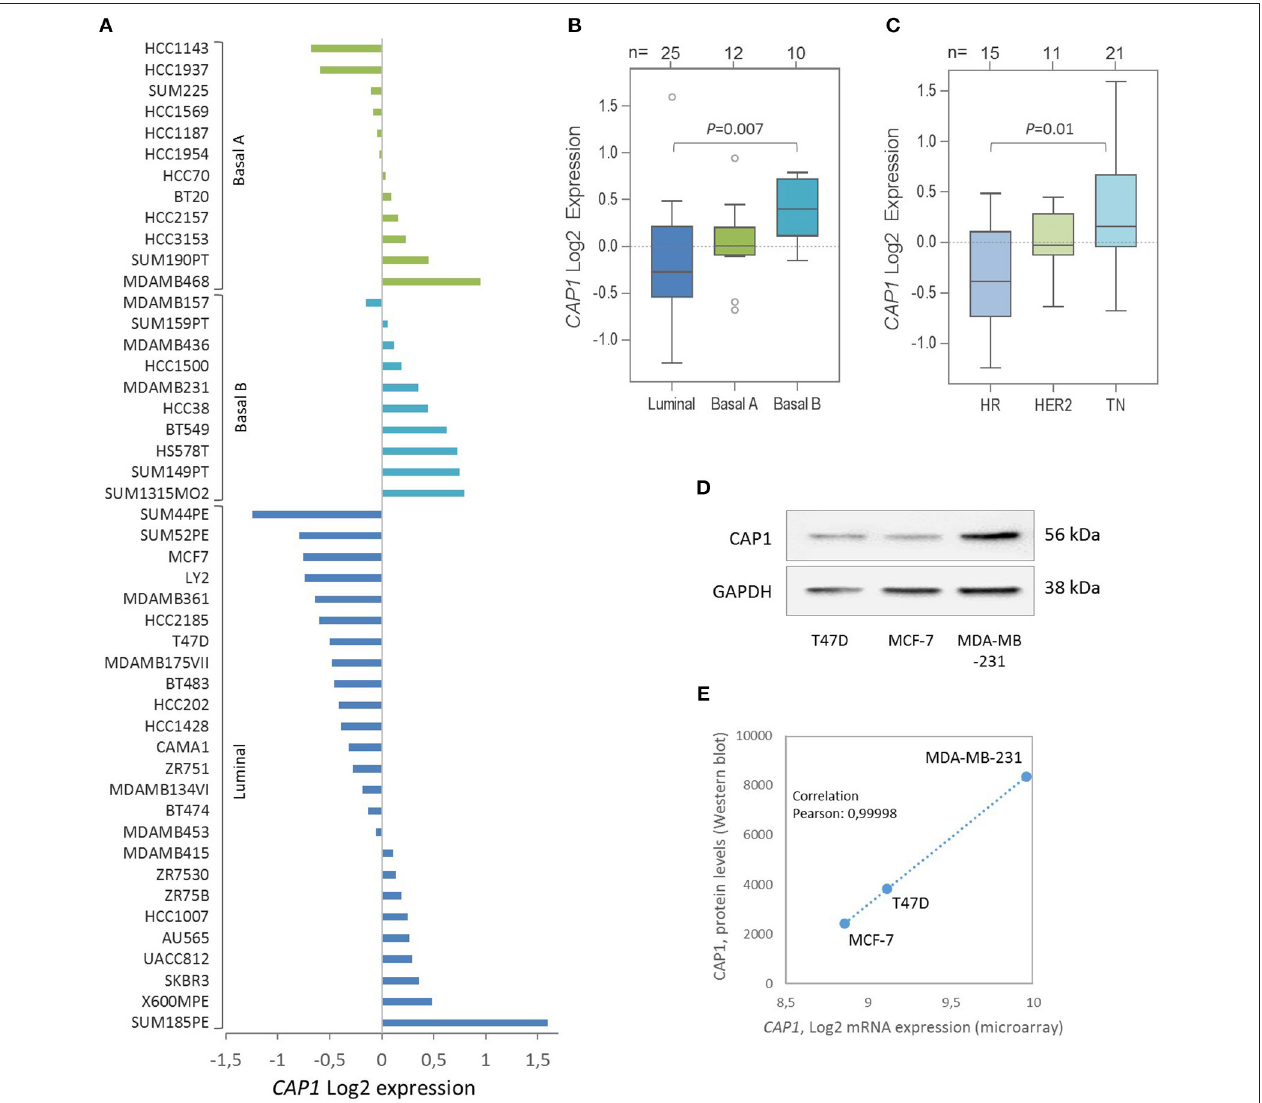
FIGURE 5 | Expression of the resistin receptor CAP1 in a panel of 47 breast cancer cell lines. (A) CAP1 gene expression across the 47 individual breast cancer cell lines, grouped as Basal A (green), Basal B (turquoise) and Luminal (blue) subtypes and shown as the relative CAP1 gene expression (Log2) across the 47 cell lines using the GOBO platform. (B , C) Boxplots of CAP1 gene expression across cell lines grouped according to (B) breast cancer subtypes or (C) hormone receptor status; hormone receptor positive (HR), HER2-positive (HER2), and triple-negative (TN), as defined by Neve et al. (22). P -values calculated by Mann Whitney-U test with Bonferroni correction. (D) CAP1 protein abundance in T47D, MCF-7 and MDA-MB-231 cells. (E) Graph demonstrate a positive correlation between CAP1 mRNA expression and protein levels in T47D, MCF-7 and MDA-MB-231 breast cancer